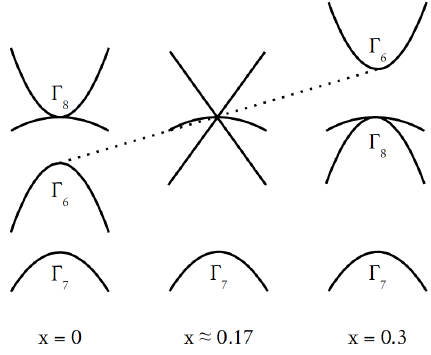
Figure 1. Evolution of bands in Hg 1 − x Cd x Te mixed crystals as a function of Cadmium content, x